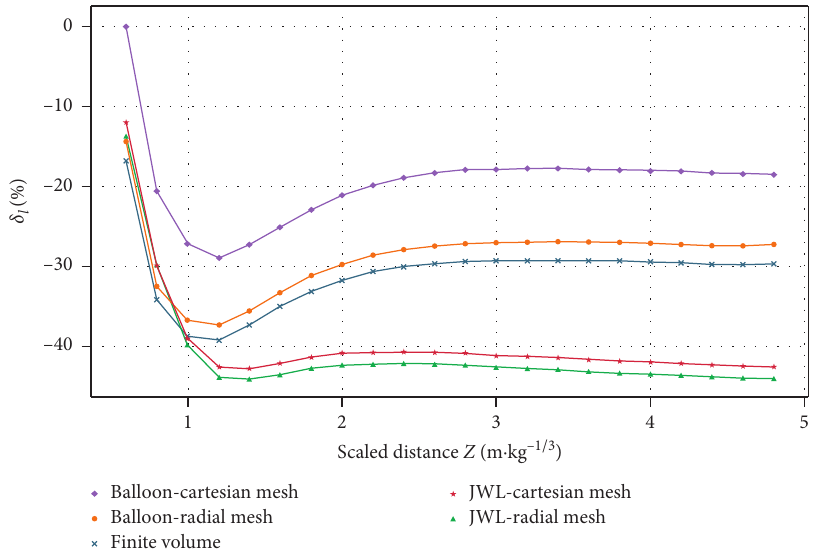
Figure 3: Relative differences with UFC-3-340-2 for overpressure, for all models as function of scaled